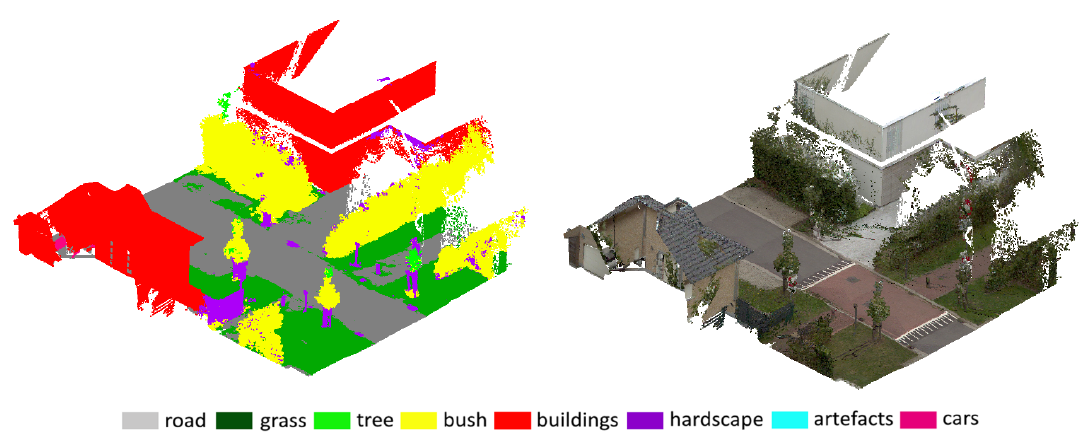
Figure 2. Semantic segmentation results from the pre-trained RandLa-Net model on section of the testing dataset. called RandLa-Net, into different general classes such as build- ing, road, vegetation and hardscape objects. Secondly, the hardscape points are clustered together and the storm drain clusters are extracted that comply with the enforced require- ments. Lastly, a minimal bounding rectangle is fitted around the surface points of the storm drain clusters in order to find the location and dimensions of each storm drain. The complete workflow is shown in Figure 1.